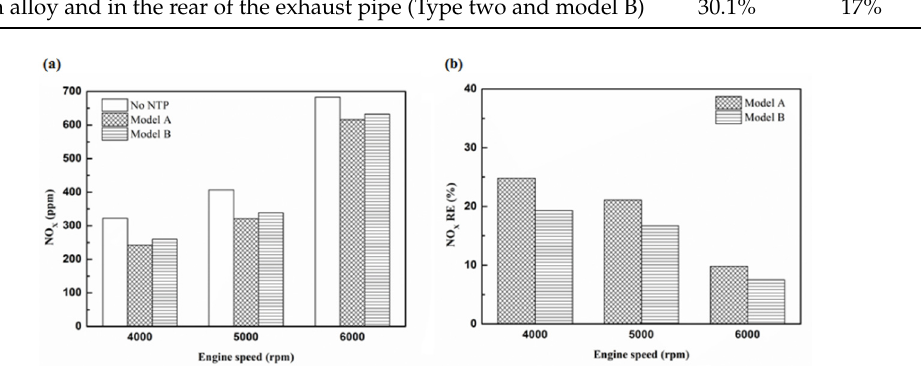
Figure 32. The NO x ( a ) emission values and ( b ) RE of control voltage 5 V using platinum.